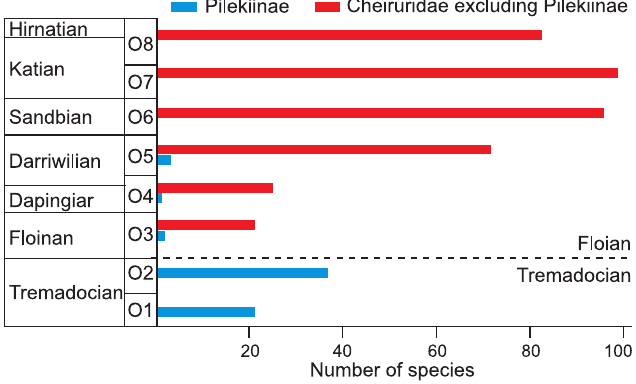
Fig. 11. Ordovician diversity of Cheiruridae species across individual time slices, as defined in Adrain (2013). The dashed line represents the bound- ary between Tremadocian and Floian; blue, members of the subfamily Pilekiinae; red, members of the rest of Cheiruridae subfamilies excluding pilekiids. Data based on Adrain (2013, personal communication